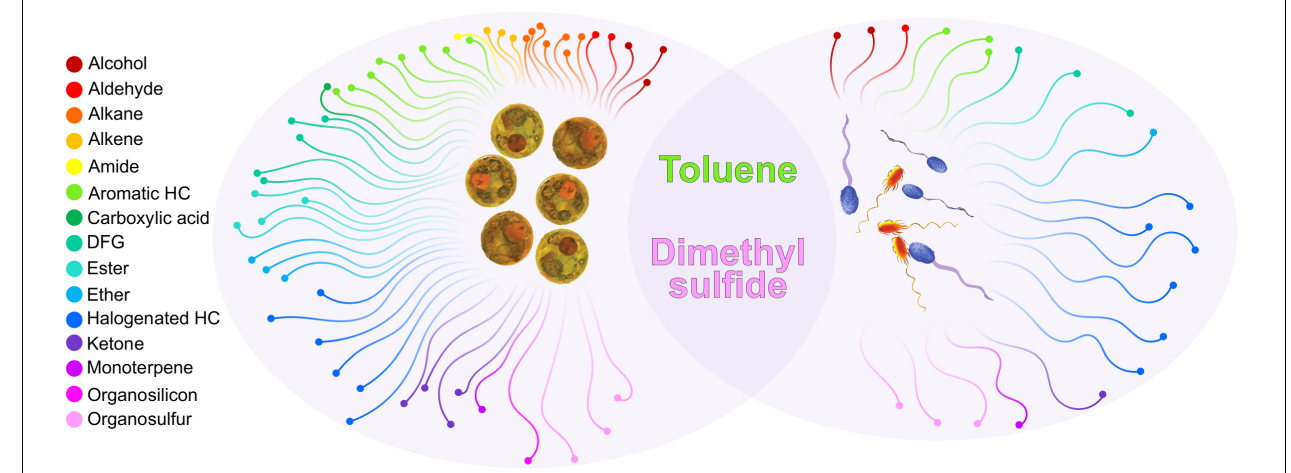
FIGURE 4 | Functional chemical groups produced by Symbiodiniaceae (left oval) and Marinobacter adhaerens and Labrenzia sp. 21p (right oval) and the compounds that were present in both (overlap). Only compounds detected in Symbiodiniaceae during ambient conditions (26 ◦ C) were included. Compounds had to be present in at least four (out of six) technical replicates in at least one species. Unclassified BVOCs were excluded from this figure, see Supplementary Table S4 for a full list of BVOCs present in Symbiodiniaceae and